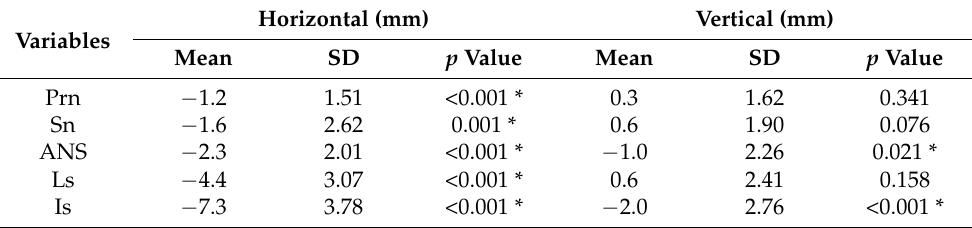
Table 2. Summary of surgical change ( n = 33). Variables